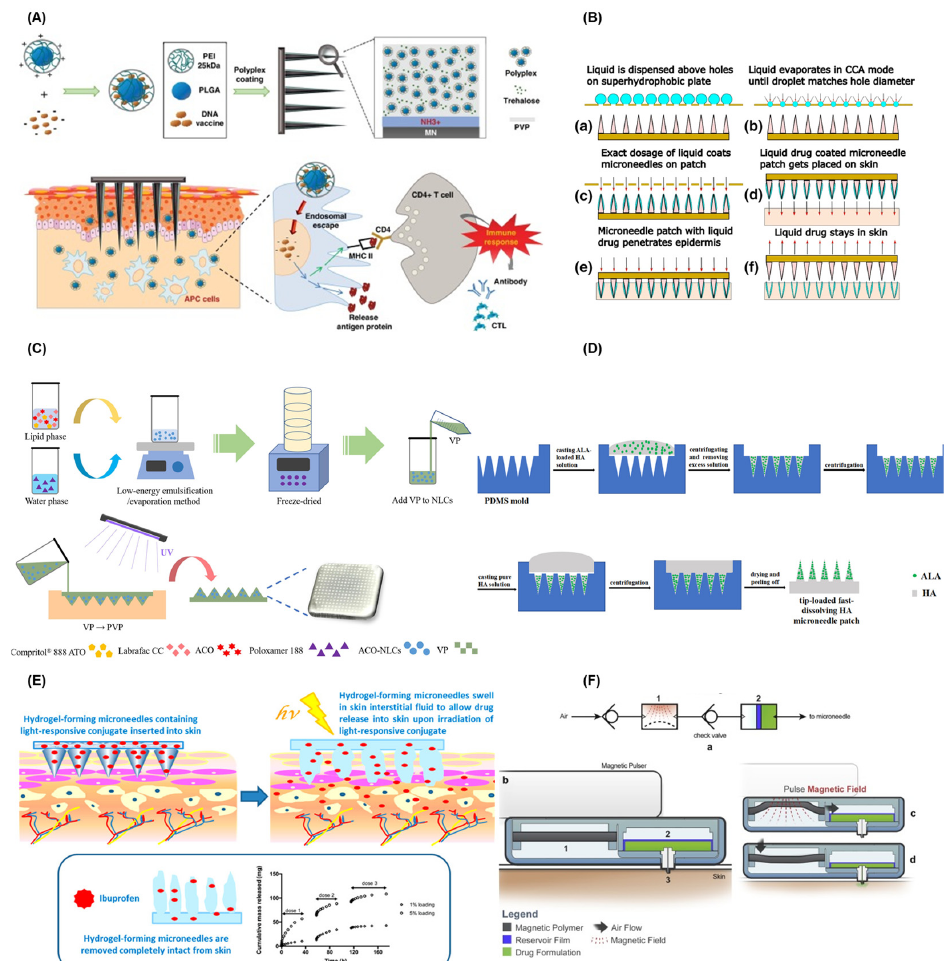
Figure 2. ( A ) Working principle diagram of ph1n1 DNA vaccine delivery platform of PLGA/PEI nanoparticle MNs. ( B ) Schematic diagram of MNs medical coating system. (a) liquid is dispensed above holes, (b) liquid evaporates in CCA mode until droplet matches hole diameter, (c) exact dosage of liquid coats MNs on patch, (d) liquid drug coated MN patch gets placed on skin, (e) MN patch with liquid drug penetrates epidermis and (f) liquid drug stays in skin. ( C ) Process diagram of the ACO–NLCs–MNs synthesis. ( D ) The process of fabricating ALA–HA fast-dissolving MNs. ( E ) Working principle of the light-responsive hydrogel MNs. ( F ) Process flow diagram of the magnetic polymer-driven MNs system. ( A ) HaeYong et al. [64]; ( B ) Andreas et al. [65]; ( C ) Guo et al. [67]; ( D ) Zhao et al. [68]; ( E ) John G. et al. [69]; ( F ) Jayaneththi et al.